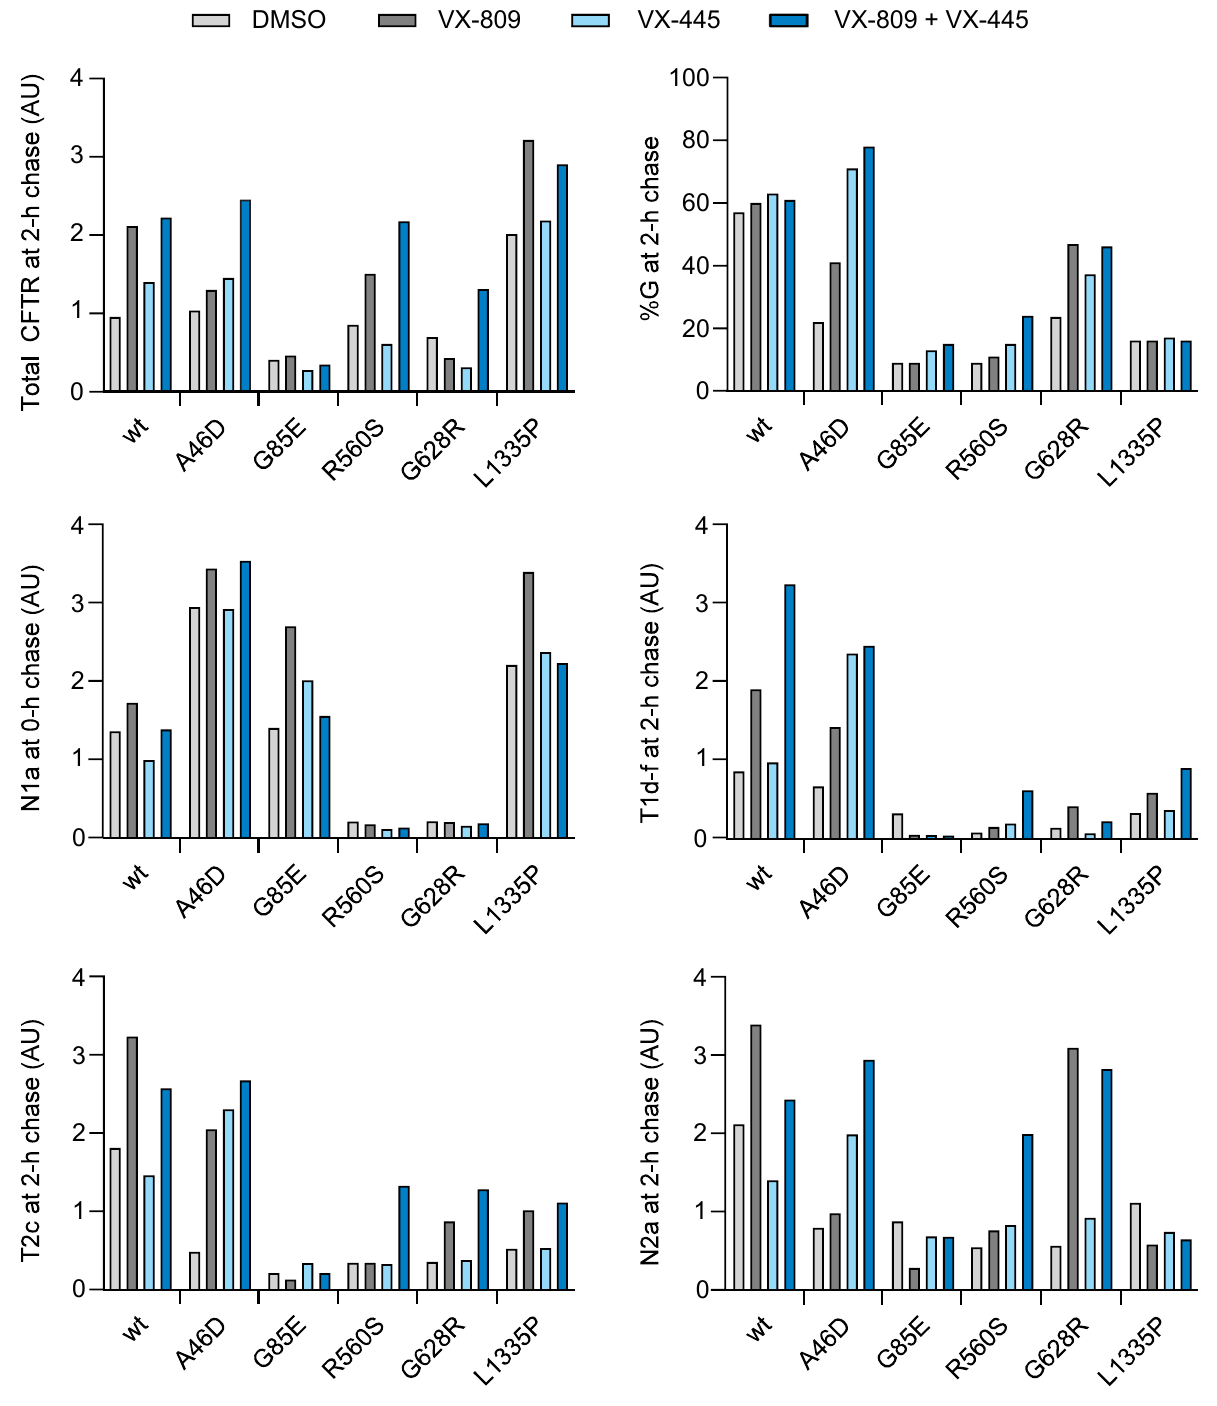
Figure 10. Quantification of hypo-responding CFTR mutants in the presence of modulators. Graphs depicting the total amount of (mutant) CFTR, percentage of CFTR that was transported to the Golgi complex, and the intensity of CFTR fragments in the presence of solvents (DMSO), VX-809, VX-445, or both, from Figure 9. G85E and L1335P were not responsive to VX-445. Neither domain folding, domain assembly, ER-to-Golgi transport, nor total amount of CFTR were affected. VX-445 clearly does not correct the primary folding defects in these mutants, nor can it rescue these mutants through improved domain